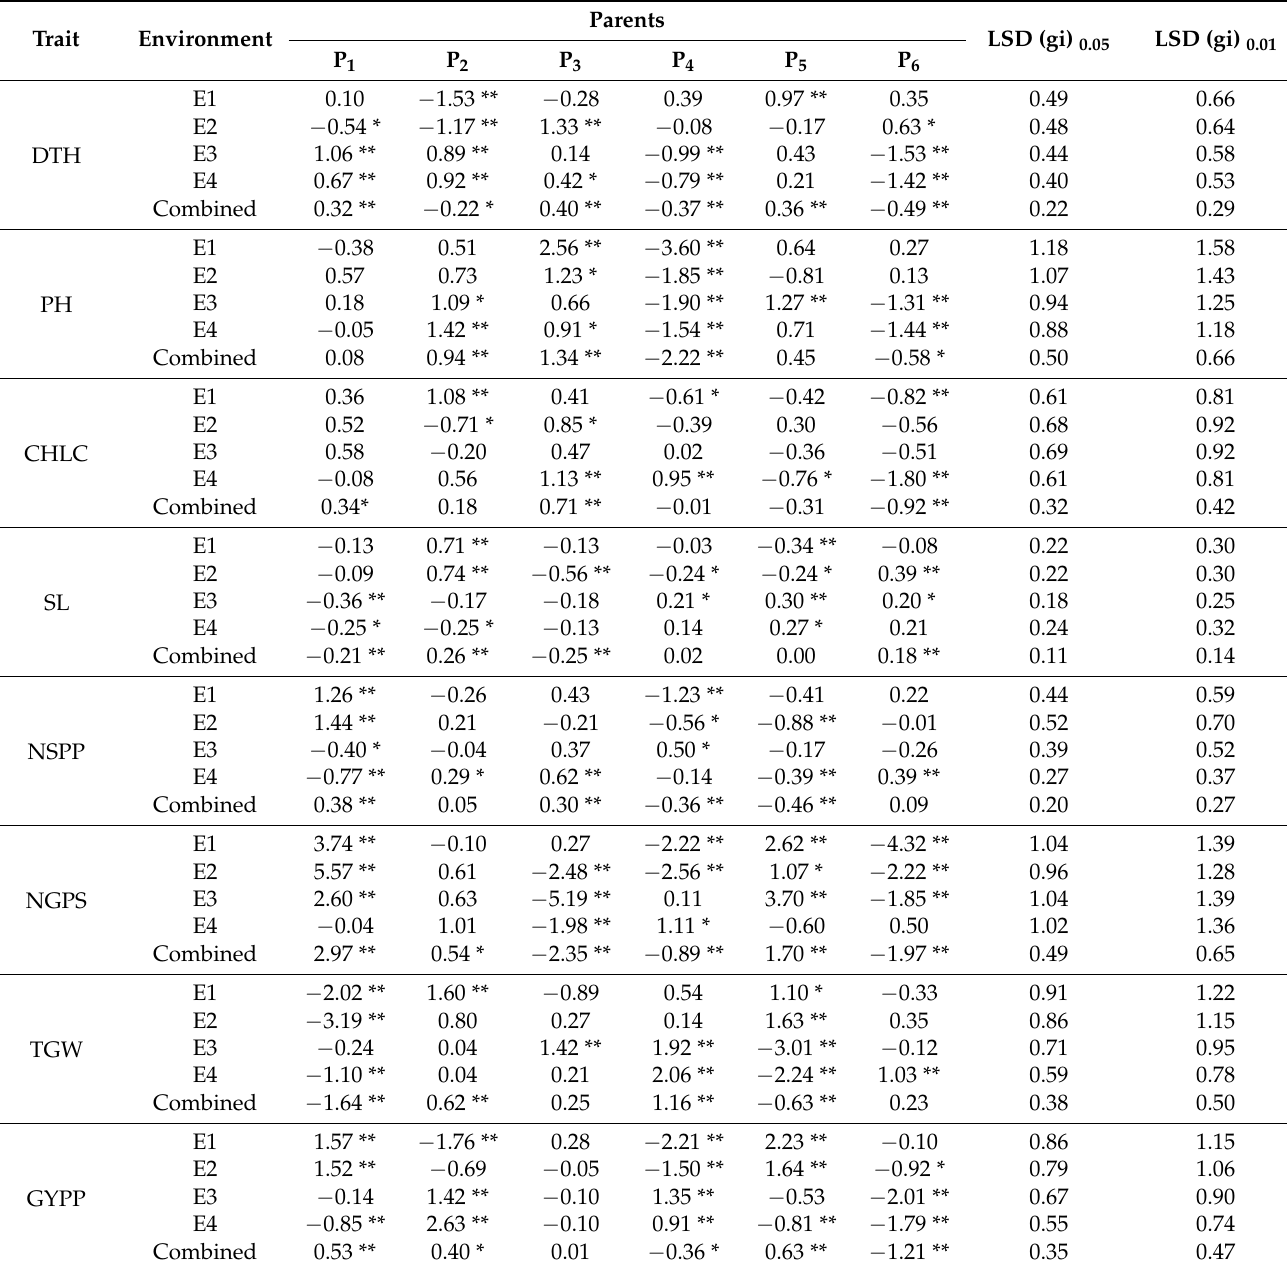
Table 2. General combining ability effects (GCA) of the used parents for all evaluated traits under tested environments. Trait